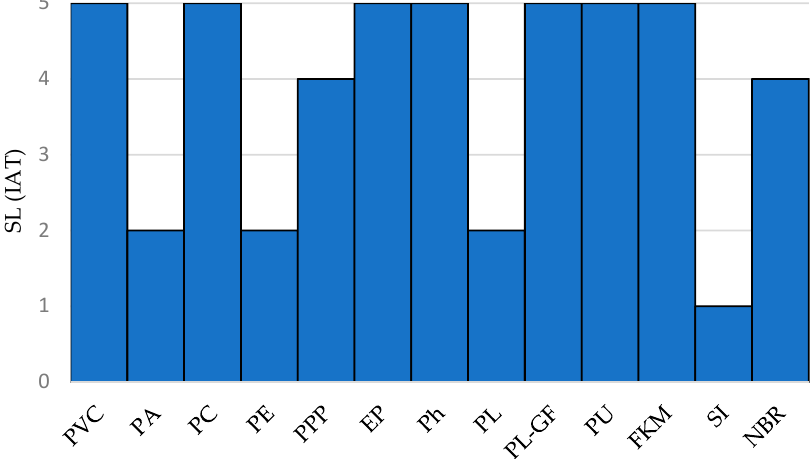
Figure 6. Irradiation aging tolerance based on the stringency level approach.